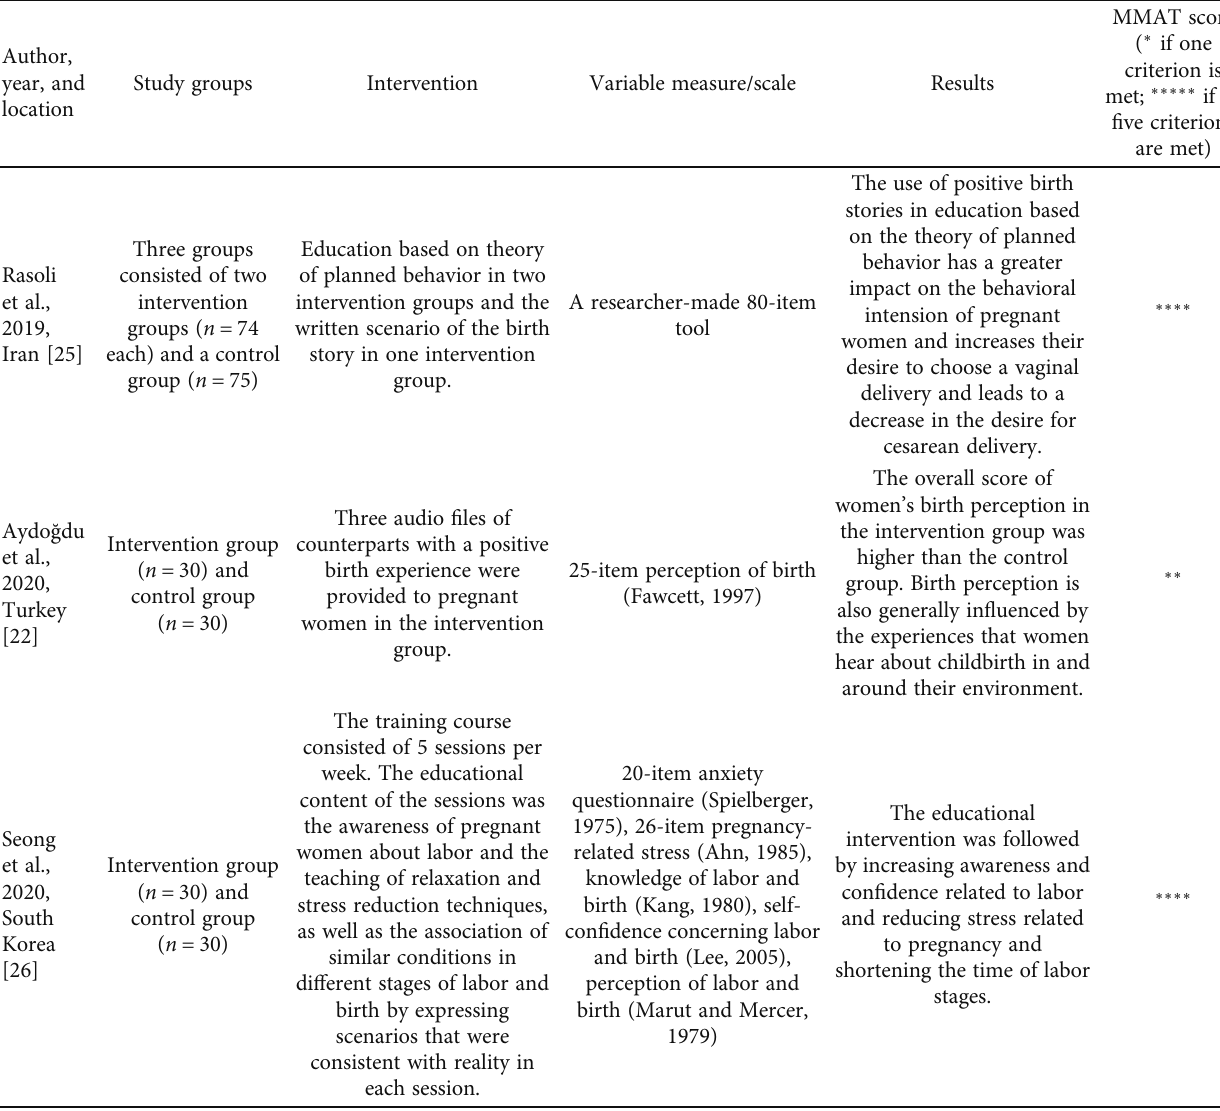
Table 1: Quantitative studies evaluating the impact of